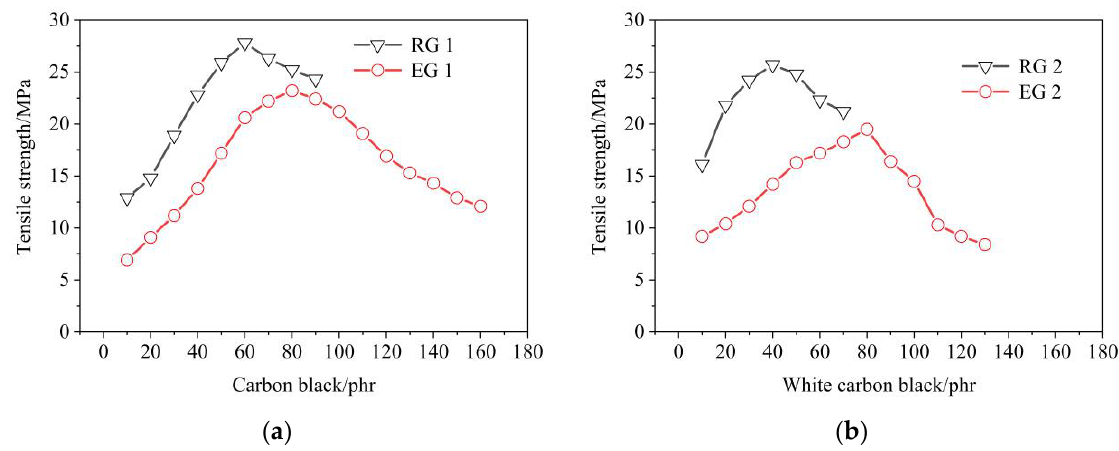
Figure 8. Effect of filler on the tensile strength of rubber samples. RG 1 and EG 1 were for SBR rubber mixtures; RG 2 and EG 2 were rubber mixtures based on NR rubber. ( a ) Effect of CB on the tensile strength of rubber samples; ( b ) Effect of WCB on the tensile strength of rubber samples.